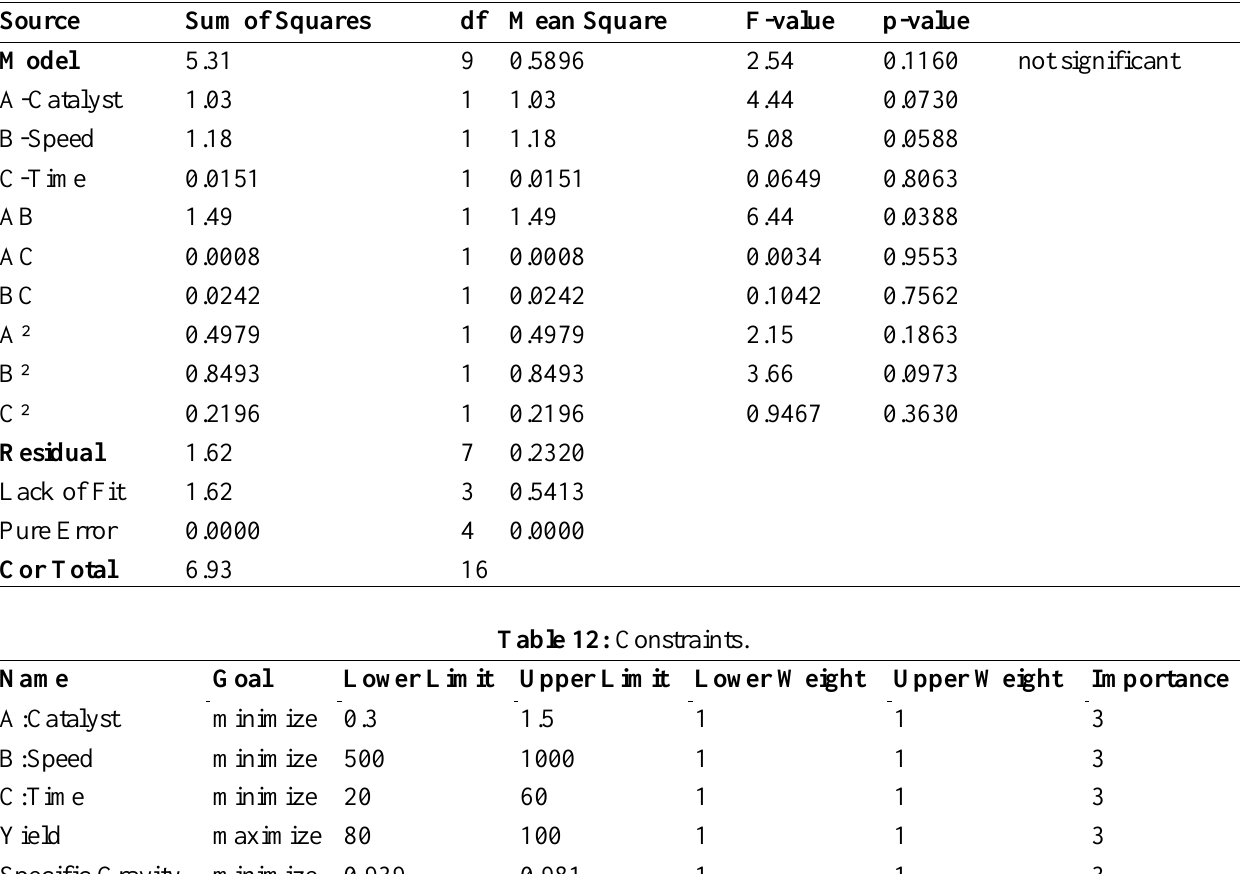
Table 11: ANOVA Table for the “Density” Quadratic model.